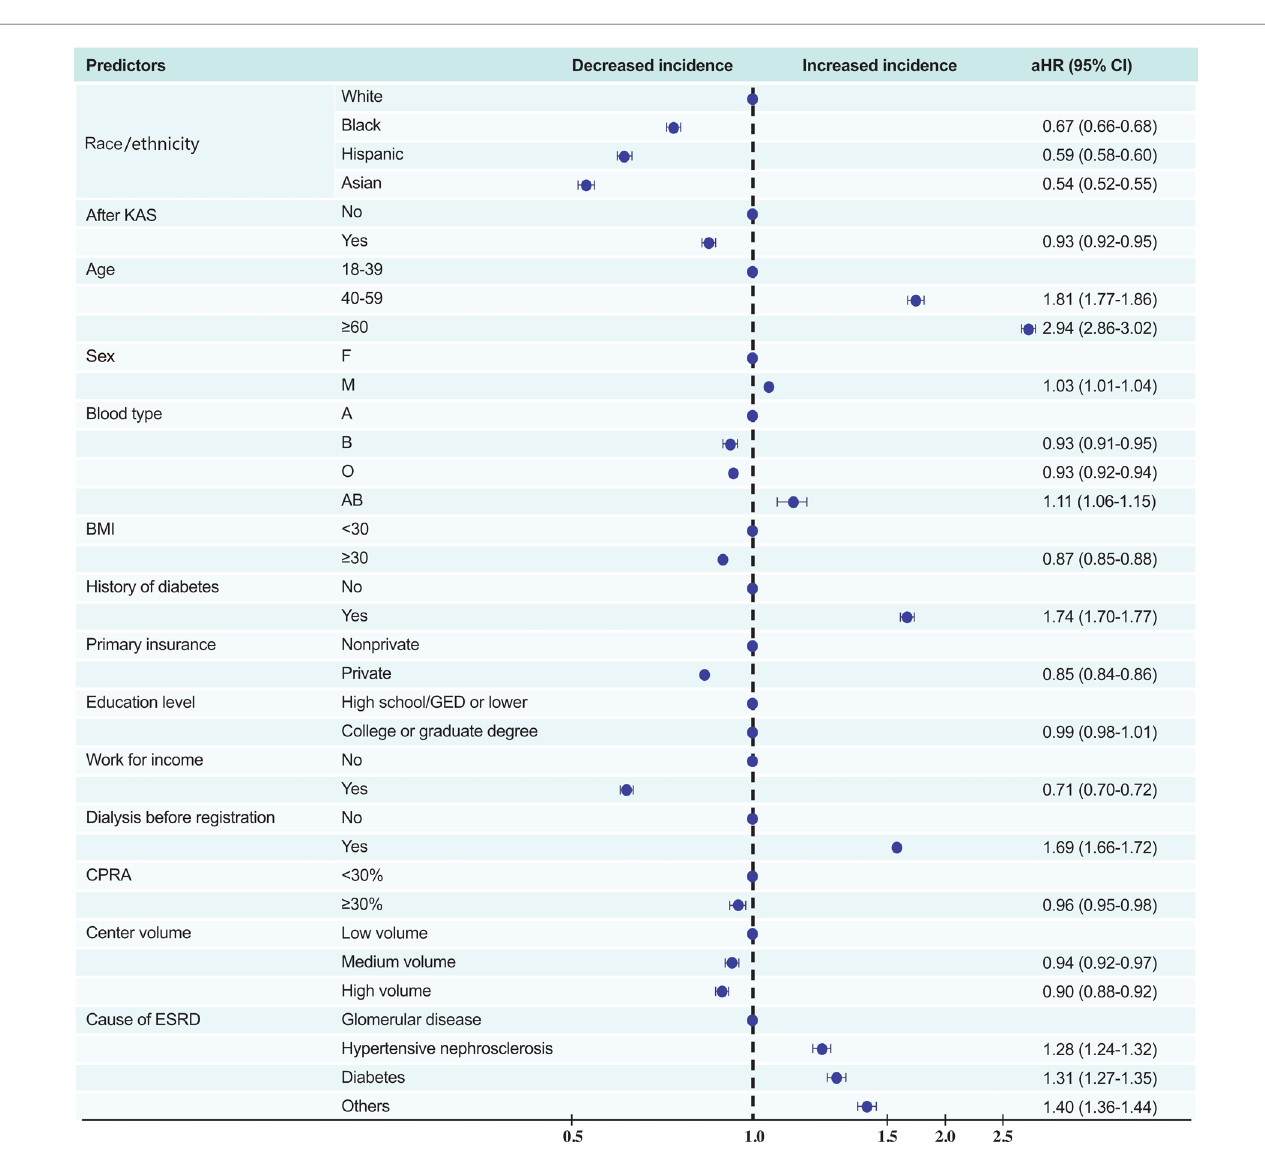
FIGURE 4 Multivariate predictors of waiting-list death or removal from the list owing to clinical deterioration. KAS, Kidney Allocation System BMI, body mass index (calculated as weight in kilograms divided by height in metres squared); CPRA, calculated panel reactive antibody; ESRD, end-stage renal disease; DM, diabetes